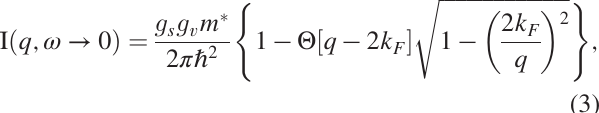
¼ 1 , 7 . 6 ð¼ ε Þ , e s